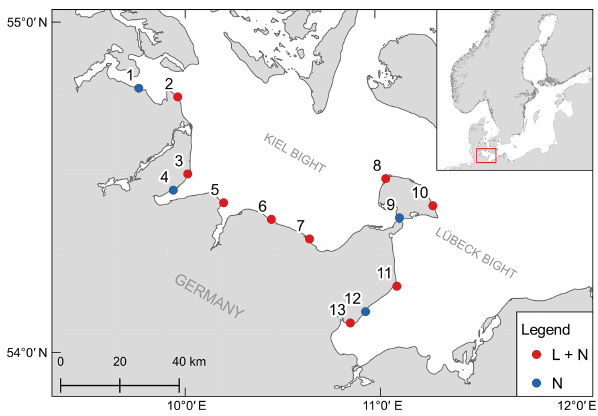
Figure 1. Geographical position of the 13 monitoring stations. Col- ors indicate if only samples for dissolved inorganic nutrients were taken (N) or if a logger station was also deployed (L + N). Table 1. Characteristics of the sampling stations in the monitoring program. Station type depicts if only samples for dissolved inor- ganic nutrients were taken (N) or if in addition continuous record- ings by data-loggers (L + N) were performed. Codes for habitat type are as follows. BF: boulder field; SB: sandy